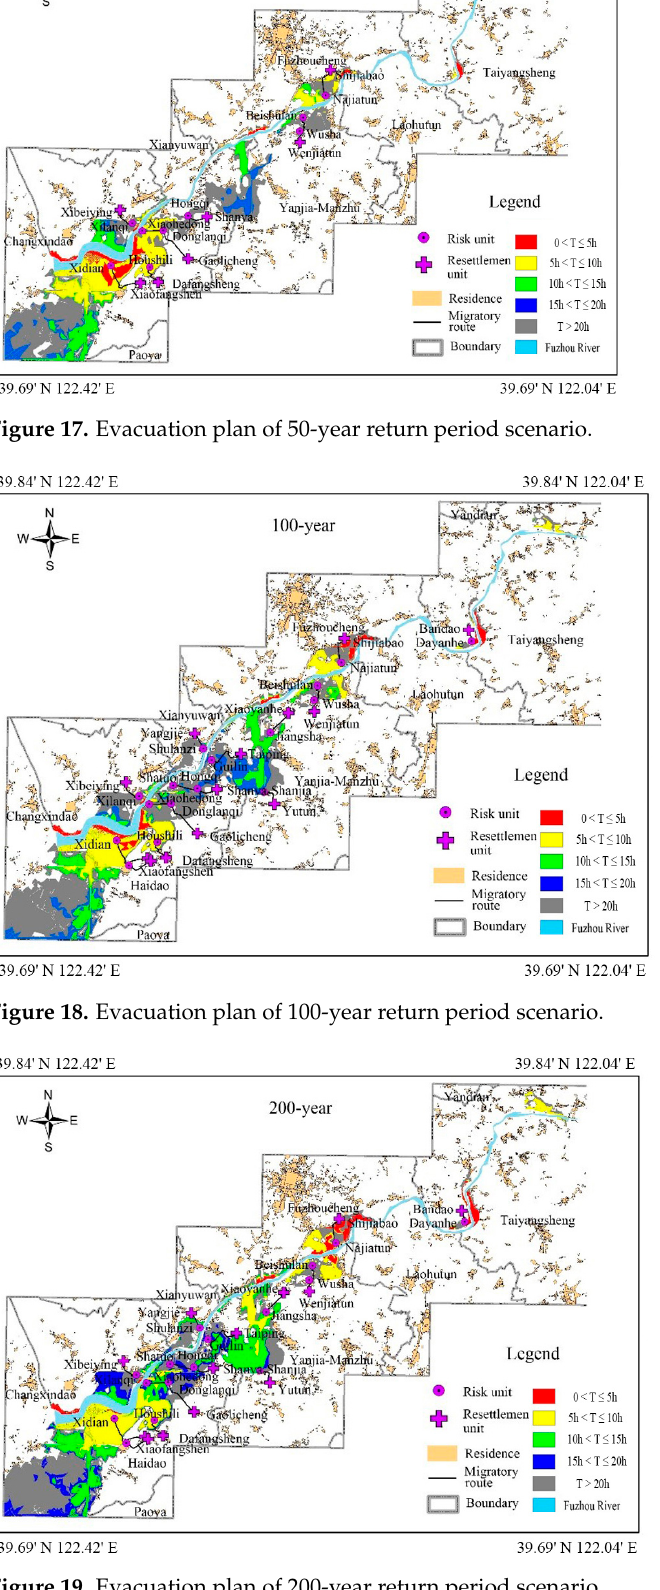
Figure 19. Evacuation plan of 200-year return period scenario. Table 3. Information of Emergency plans.